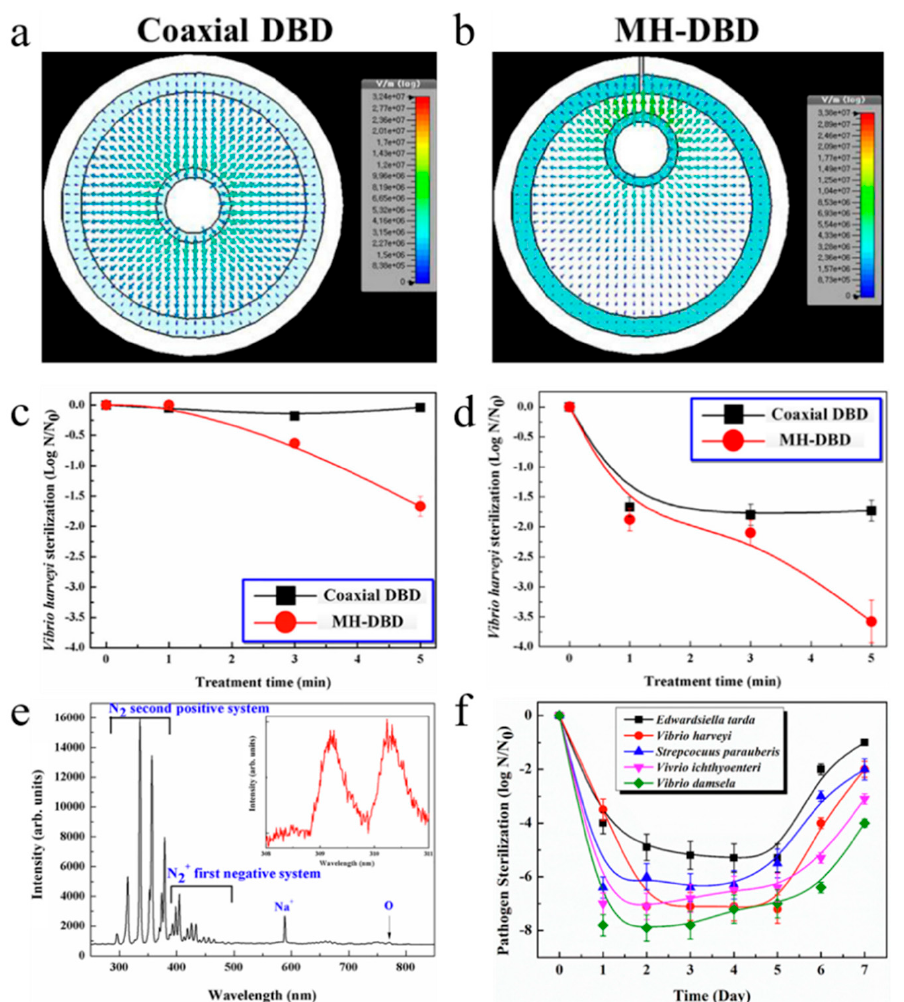
Figure 12. ( a ) graphical abstract; ( b ) the impact of relative humidity on decomposition efficiency at different frequencies; ( c ) Lissajous figures of different discharge regions; ( d ) effect of specific energy density on CO 2 selectivity and decomposition efficiency. Reproduced with permission from [137]; Copyright Elsevier, 2018.